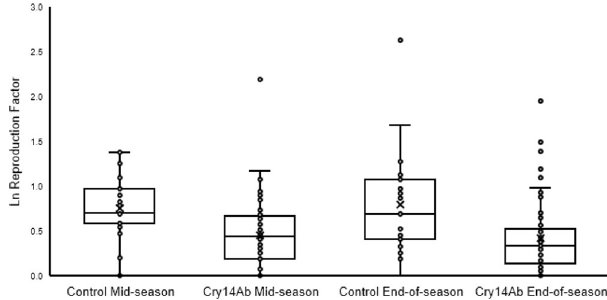
Fig. 10 The ability of Cry14Ab to reduce Heterodera glycines reproduction in the fi eld was assessed in the PI 88788-derived soybean variety Jack. Untransformed plants and negative control events transformed only with a selection vector (Control) were compared to multiple Cry14Ab-expressing events (Cry14Ab). Soybean plants were grown in a H. glycines- infested fi eld in Webster County, IA in 2010 and 2011. Soil core samples were taken to assess the population density of H. glycines at planting, ~60 days after planting (mid-season), and at harvest (end-of-season). A reproduction factor was calculated for mid-season ( n = 26 plots for control, n = 66 plots for Cry14Ab) and end-of-season ( n = 26 plots for control, n = 65 plots for Cry14Ab), by dividing the population density at the assessment time by the population density at planting. The natural log of the reproductive factor plus one is displayed. Data were natural log (ln) transformed and analyzed with an ANOVA. Contrast statements were used to compare control and Cry14Ab treatments with an F -test. Cry14Ab-expressing soybean reduced H. glycines reproduction at both the mid-season ( P = 0.00179) and end-of- season ( P = 0.00156) assessment times. In examining non-transformed data, mid-season reproduction was reduced by 43%, from a reproduction factor of 1.25 ± 0.8 – 0.71 ± 1.06 and end-of-season reproduction was reduced by 60%, from a reproduction factor of 1.67 ± 2.52 – 0.67 ± 1.0. Box plots depict the median (middle line), average ( x ), 25th and 75th percentile (box), and 5th and 95th percentile (whiskers) as well as all data points. Source data are provided as a Source Data fi